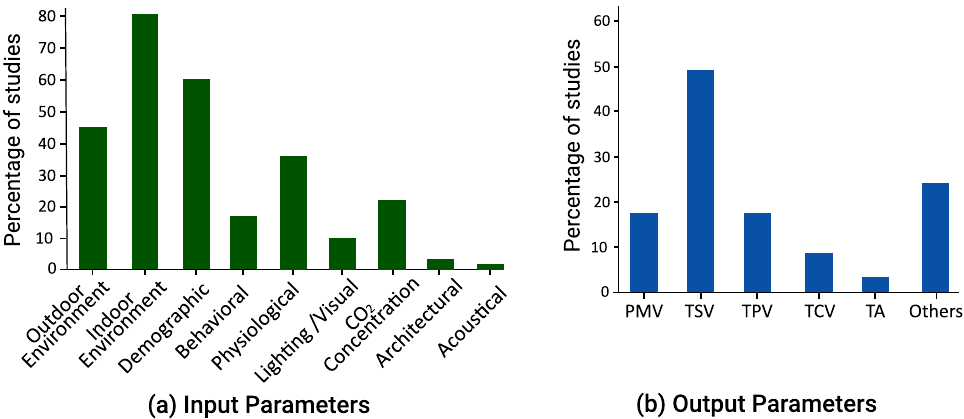
Figure 7. Distribution of ( a ) Input Parameters (Features) and ( b ) Output Parameters (Labels) of MLTC